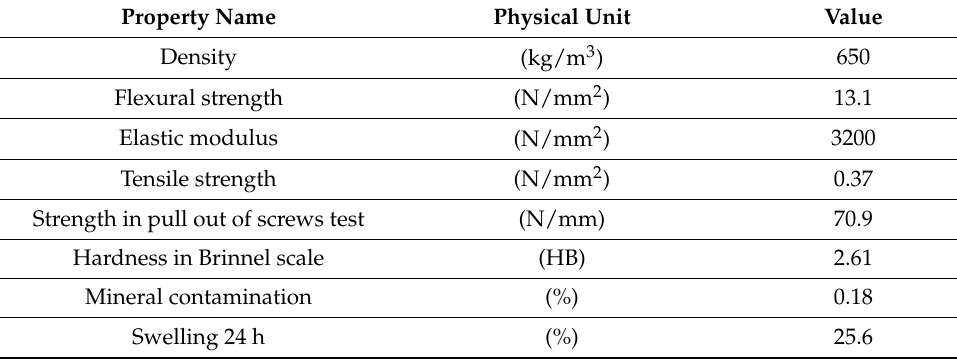
Table 1. Basic physical and mechanical properties of the particleboard [8].